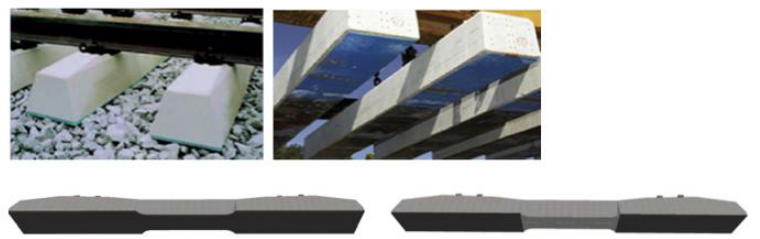
Figure 2. The under sleeper pads with fully covered bottom surface and partially covered bottom surface of the railway sleeper (under rail section) [2,30].